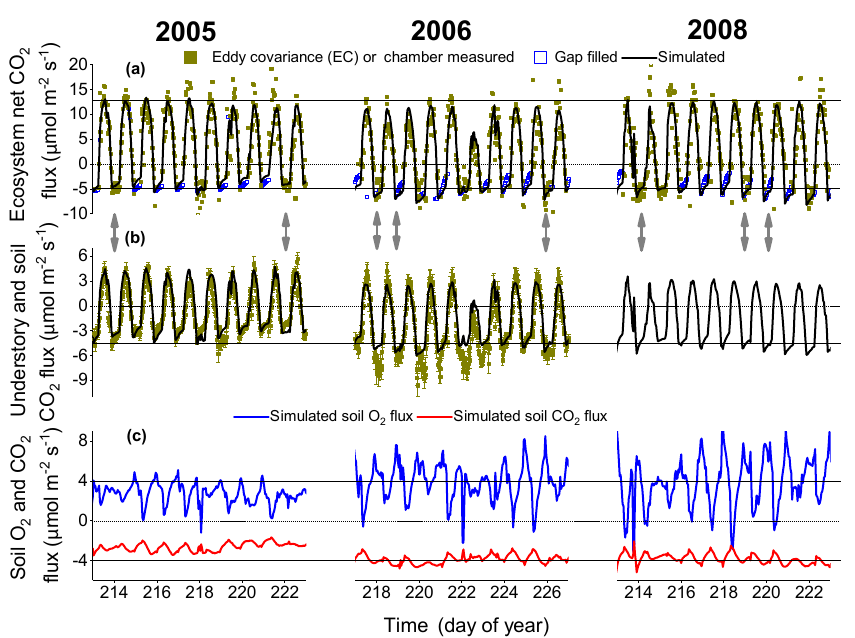
Figure 5. (a) Half-hourly EC-measured and gap-filled (Flanagan and Syed, 2011) and hourly modeled ecosystem net CO 2 fluxes, (b) half- hourly automated chamber-measured (Cai et al., 2010) and hourly modeled understory and soil CO 2 fluxes, and (c) hourly modeled soil CO 2 and O 2 fluxes during August of 2005, 2006 and 2008 at a western Canadian fen peatland. No chamber CO 2 flux measurement was available for 2008. Bars represent standard errors of means of chamber CO 2 fluxes ( n = 9). A negative flux represents an upward flux or a flux out of the ecosystem, and a positive flux represents a downward flux or a flux into the ecosystem. Grey arrows indicate nights with similar temperatures in the same way as in Fig.